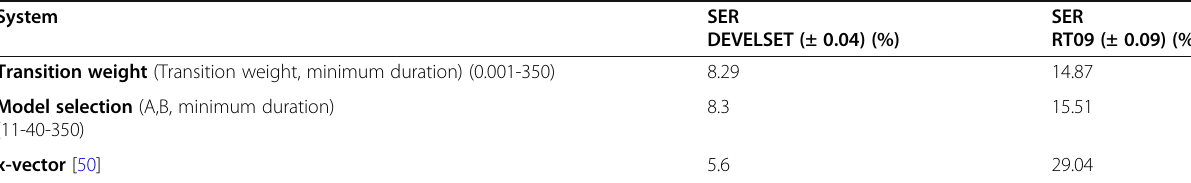
Table 15 Comparison of the results of our system with an x-vector system System